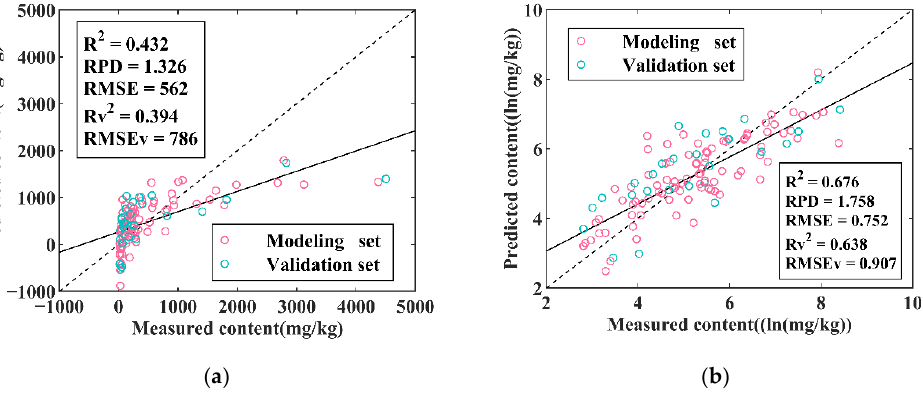
Figure 4. Scatter plot of the measured and predicted values. ( a ) soil Pb content, and ( b ) log- transformed soil Pb content.